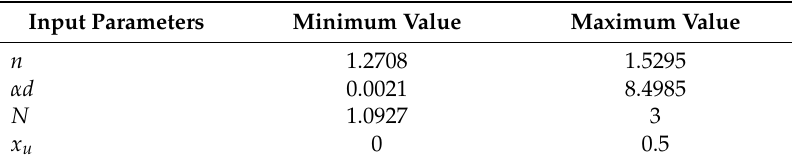
Table 1. Ranges of input parameters. n is the refractive index, α d is the diametrical absorbance, N is the number of sublayers, x u is the particle backscattering